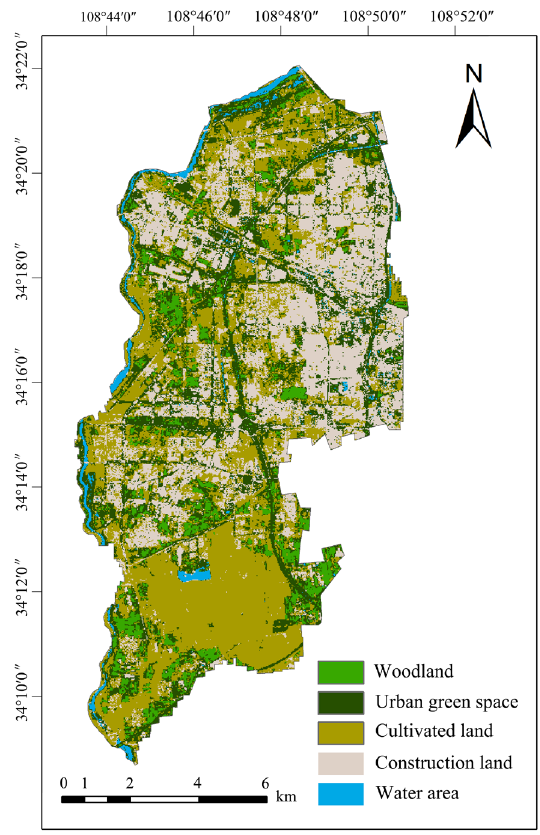
Figure 3. Landscape resistance factor.